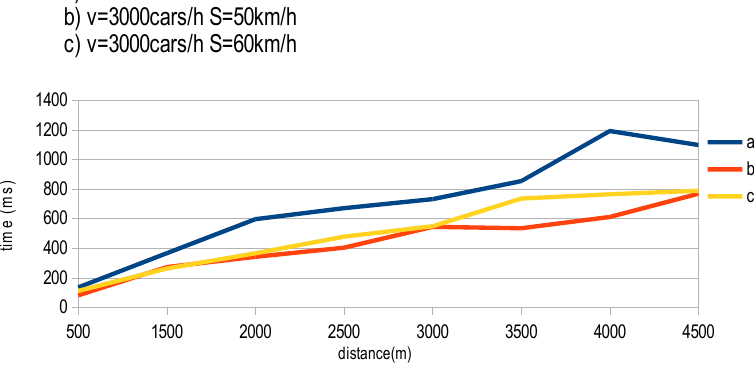
Figure 6. Packet delivery time with the distance between RSU stations for scenario (B).